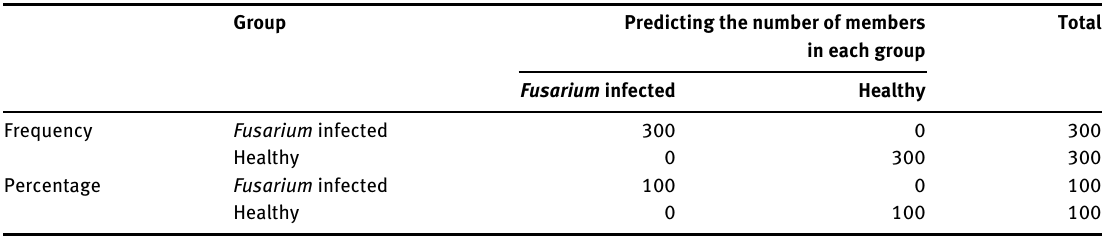
Table 4: Classification Results by Discriminant Analysis Method with Texture Characteristics.